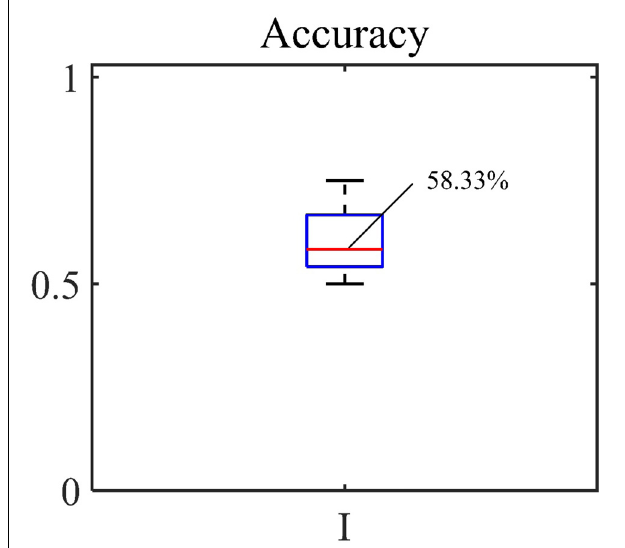
FIGURE 10 | Accuracy of the comparison